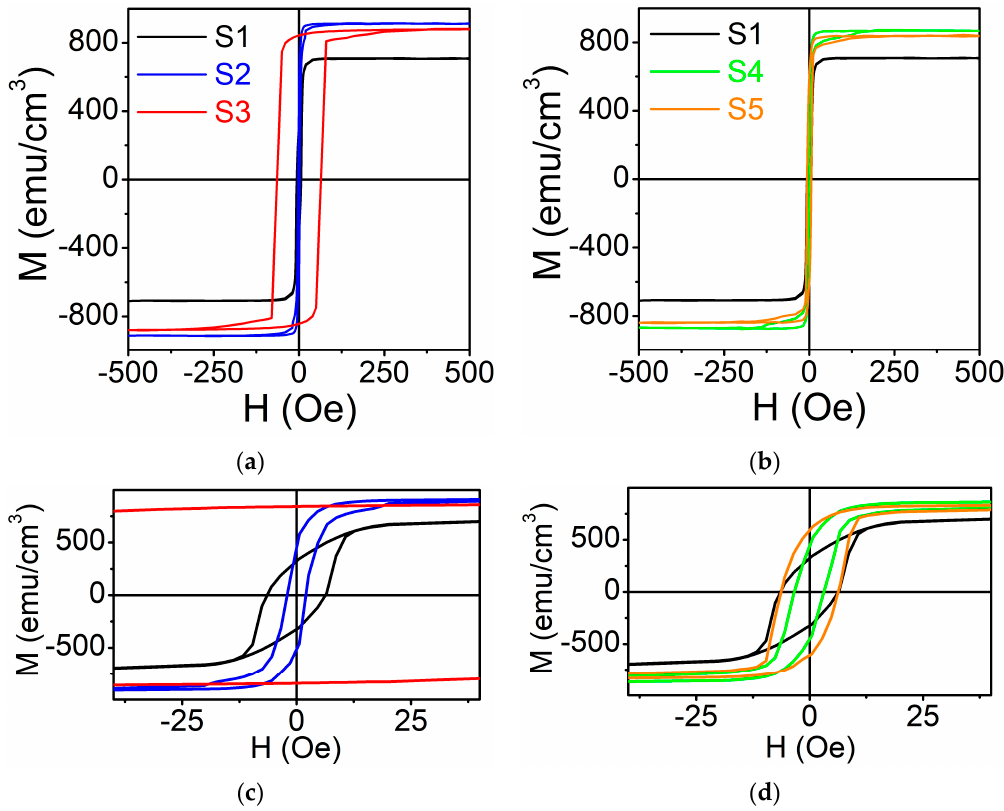
Figure 3. Magnetic hysteresis loops (M vs. H) for Co 2 FeGe films: ( a ) deposited at T S = RT (S1), T S = 573 K (S2), T S = 773 K (S3); ( b ) deposited at RT and annealed for 1 h at T a = 573 K (S4), T a = 773 K (S5). Close-ups for -30 Oe < H < 30 Oe region for films: ( c ) deposited at different T S ; ( d ) for films deposited at RT and annealed at different T a for 1 h.